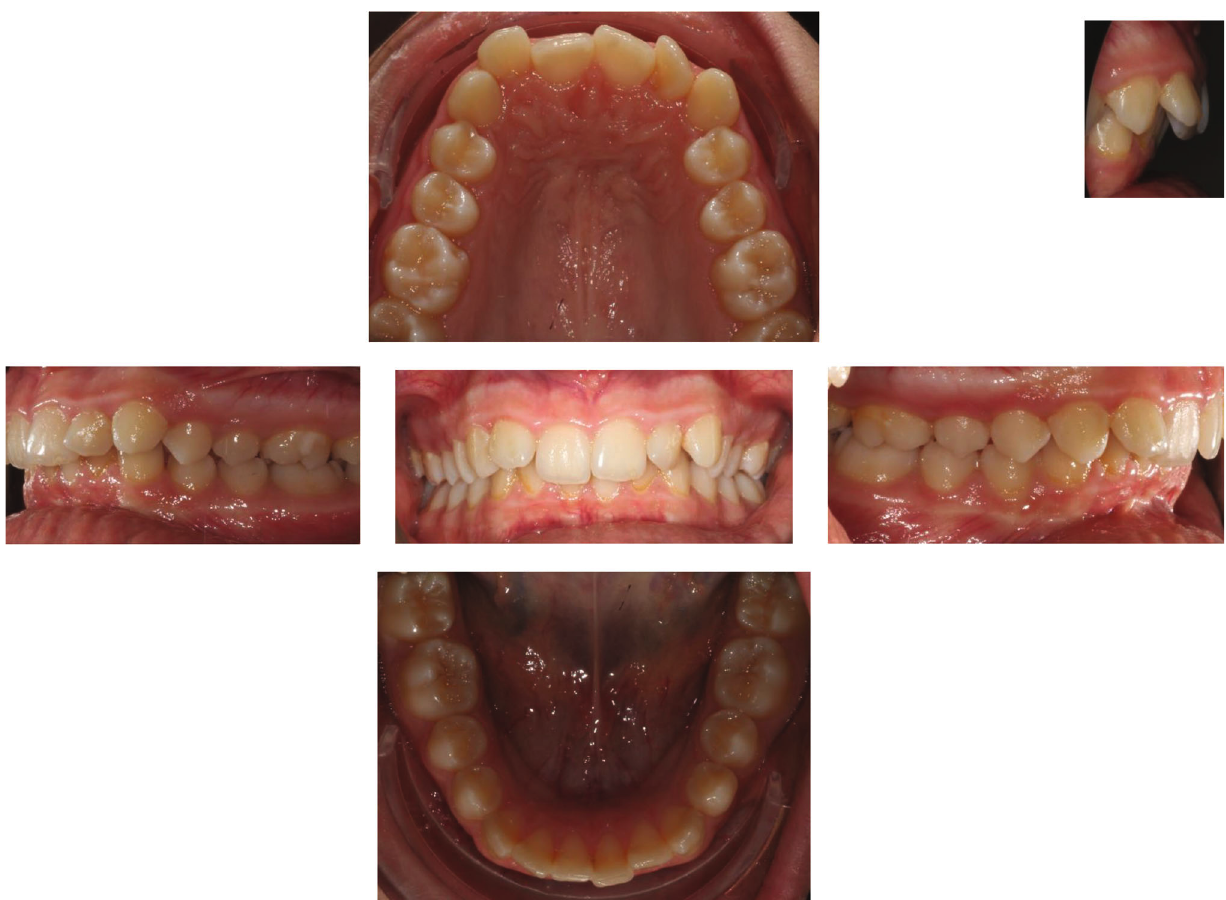
Figure 4: Initial intraoral